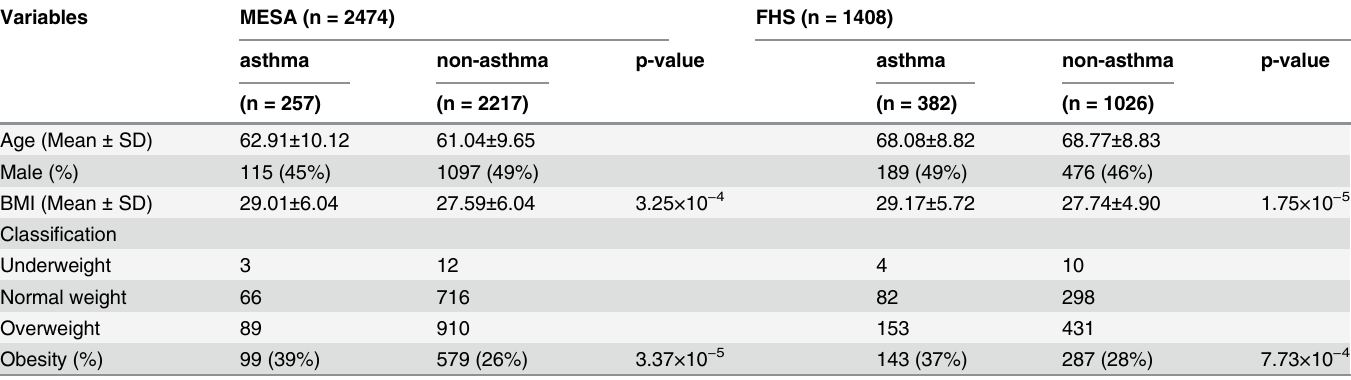
Table 1. Characteristics of subjects in MESA and FHS. Participants who were included in the final interaction analyses are summarized. In MESA, age is based on the screening exam; in FHS, age is based on the 8 th exam with 5-year intervals. Classification was based on BMI, as follows: underweight (BMI < 18.5); normal weight (18.5 < = BMI < 25); overweight (25 < = BMI < 30); obesity (BMI > = 30).